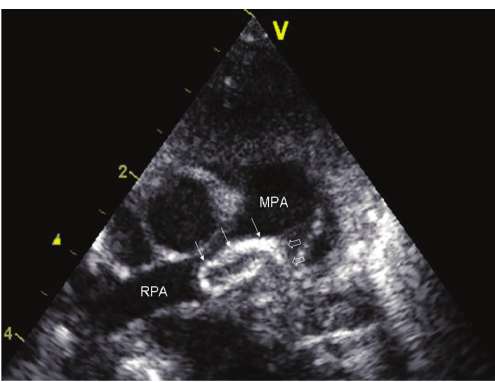
Figure 1: Cross-sectional echocardiogram showing the protrusion of the echodense mass (arrows) into the right pulmonary artery, extending from obstructed left pulmonary artery (block arrows). MPA: main pulmonary artery. RPA: right pulmonary